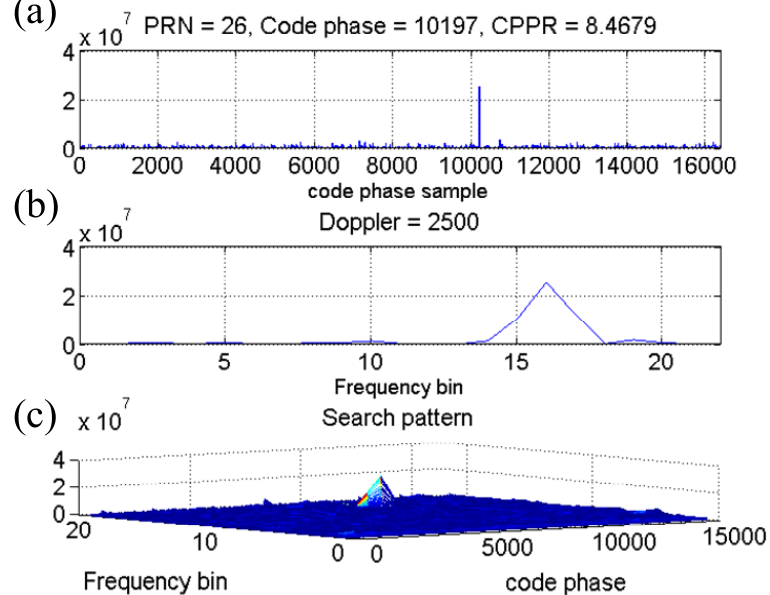
Figure 8. (a) The correlation distribution versus the code delay samples of PRN 26 at the frequency bin with maximum correlation peak. (b) The correlation distribution versus the frequency bin of PRN 26 at the code delay sample with maximum correlation peak. (c) The search pattern of the PRN 26 of the outdoor collected signal in the acquisition process.